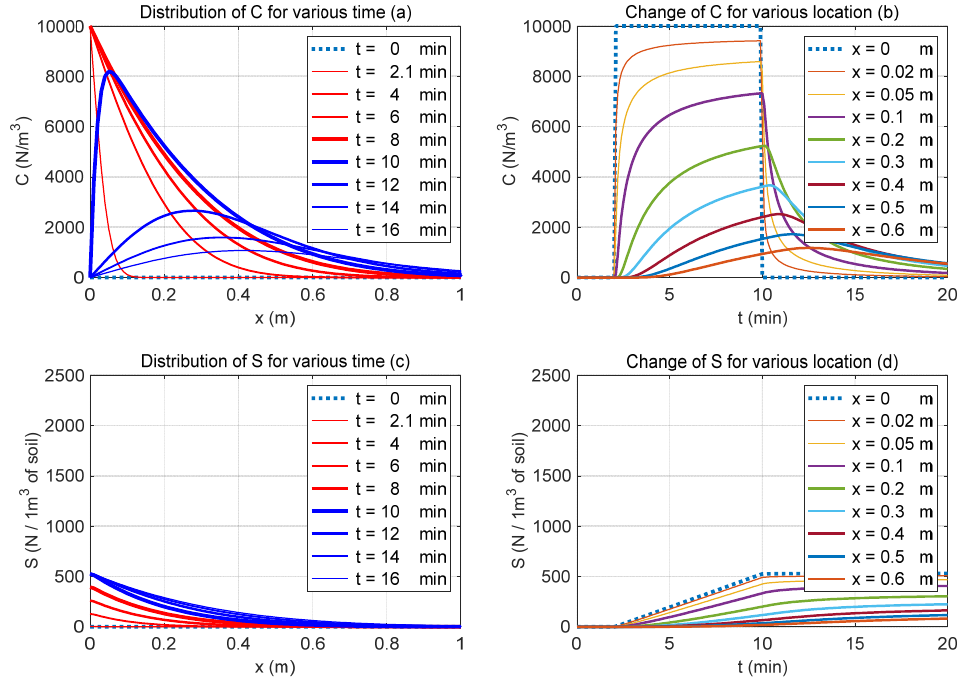
Figure 7. Simulation results for case S4 ( k a = 0.5 k a 0 ): ( a ) distribution of C at various times, ( b ) variation in C at various locations, ( c ) distribution of S at various times, and ( d ) variation in S at various locations.